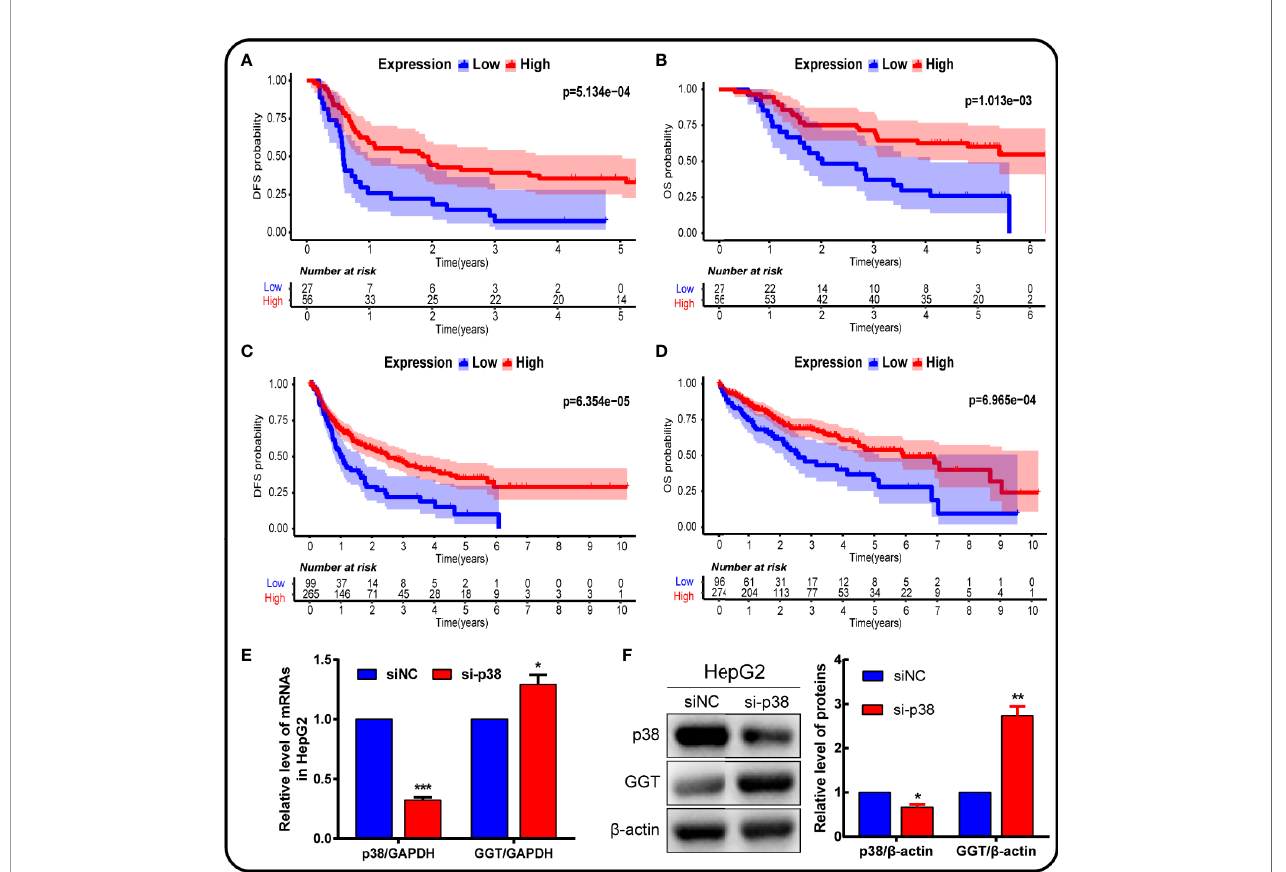
FIGURE 9 | P38MAPK plays a vital role in prognosis and regulates GGT expression in HepG2 hepatoma cells. The prognosis of P38MAPK expression was analyzed using own data (A, B) and data from TCGA database (C, D) . (E) qPCR analysis of p38MAPK and GGT mRNA expression in HepG2 cells transfected with si-p38MAPK and siNC for 24 h. GAPDH was used as a loading control. (F) Western blotting analysis of p38MAPK and GGT protein expression in HepG2 cells transfected with si-p38MAPK and siNC for 24 h. b -Actin was used as a loading